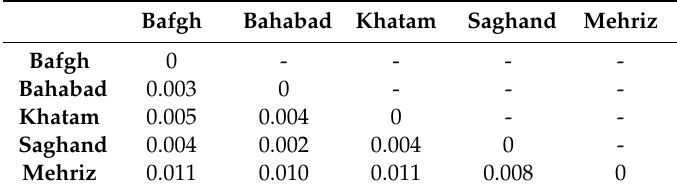
Figure 5. ADMIXTURE plots of 5 dromedary camel populations in the Iranian central desert. Table 3. Pairwise F ST among populations of Iran’s central desert